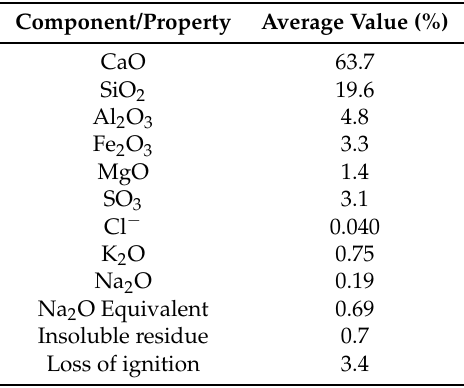
Table 2. Chemical properties of Cement CEM I 42.5 R (Mokrá cement plant) according to EN 196-2 [41].